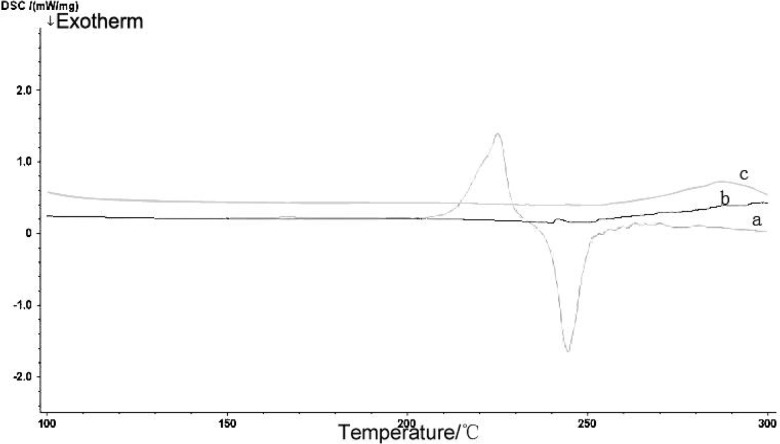
Differential scanning calorimetry (DSC) thermograms of (a) PTX, (b) blank mixed micelles, and (c) PTX-loaded mixed micelles.